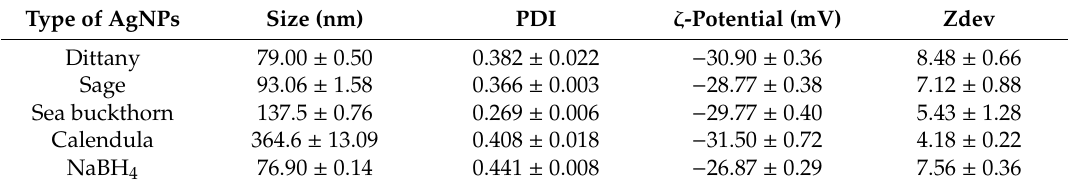
Table 1. Physicochemical characterization of AgNPs (mean values ±